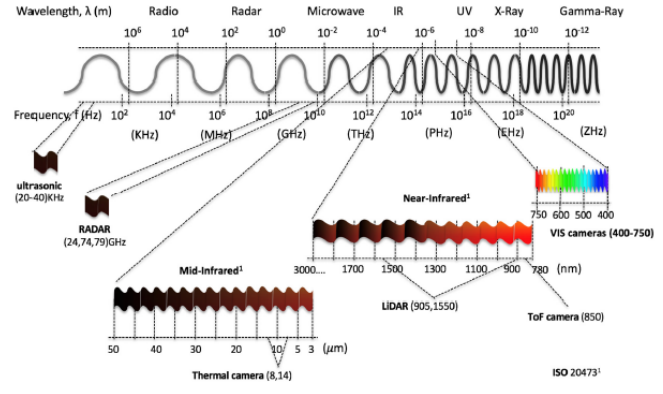
Figure 3. Electromagnetic spectra used by sensors on autonomous